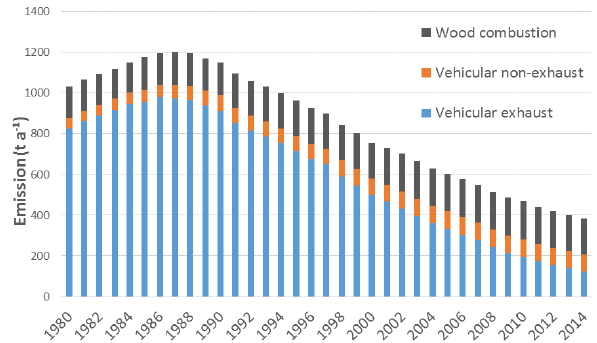
Figure 6. The predicted emissions that originated from vehic- ular sources and small-scale wood combustion in the Helsinki Metropolitan Area from 1980 to 2014. The vehicular emis- sions have been presented separately for exhaust and non-exhaust sources. The values for the vehicular exhaust emissions have been extracted from the LIPASTO system (Mäkelä and Auvinen,